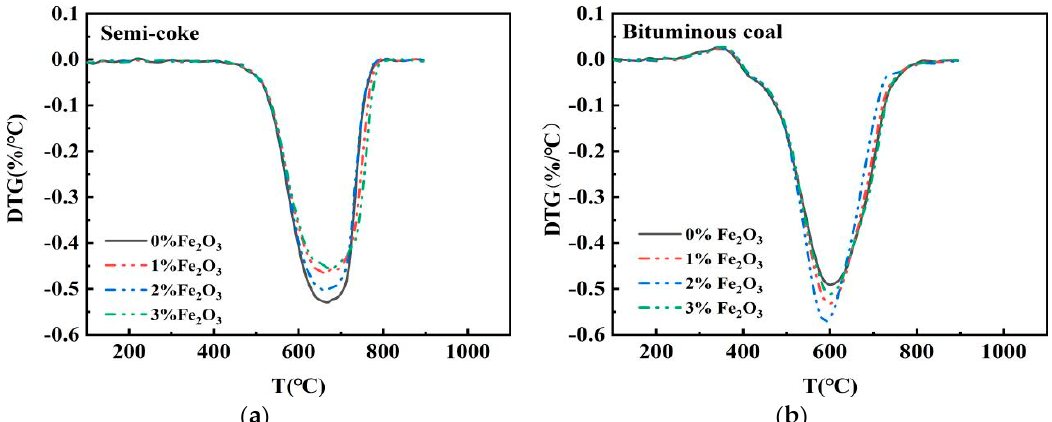
Figure 4. DTG curves for ( a ) semicoke and ( b ) bituminous coal at different addition levels of Fe 2 O 3 .